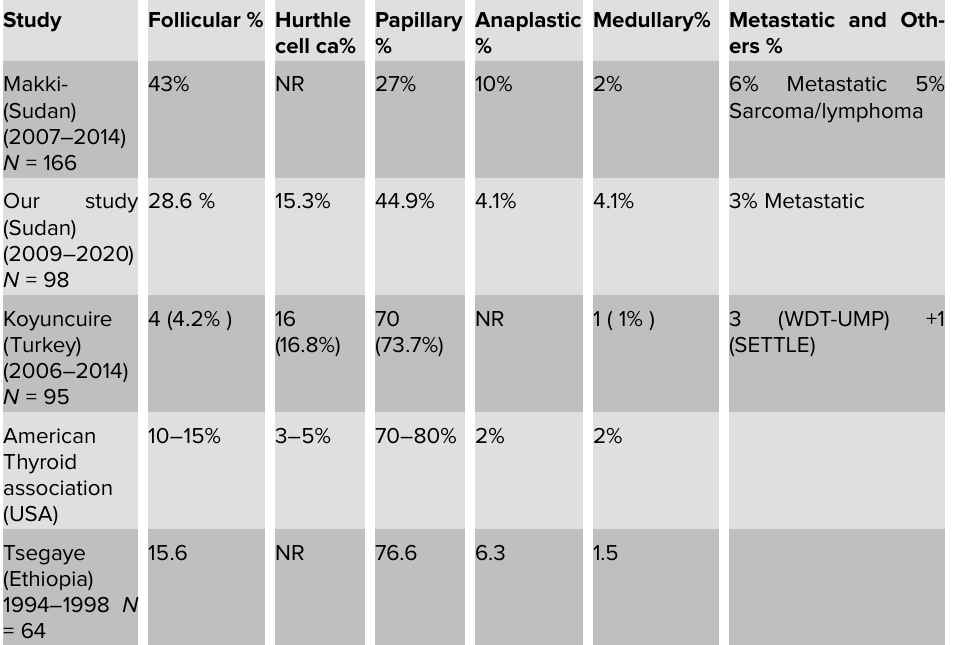
Table 5: Thyroid cancer